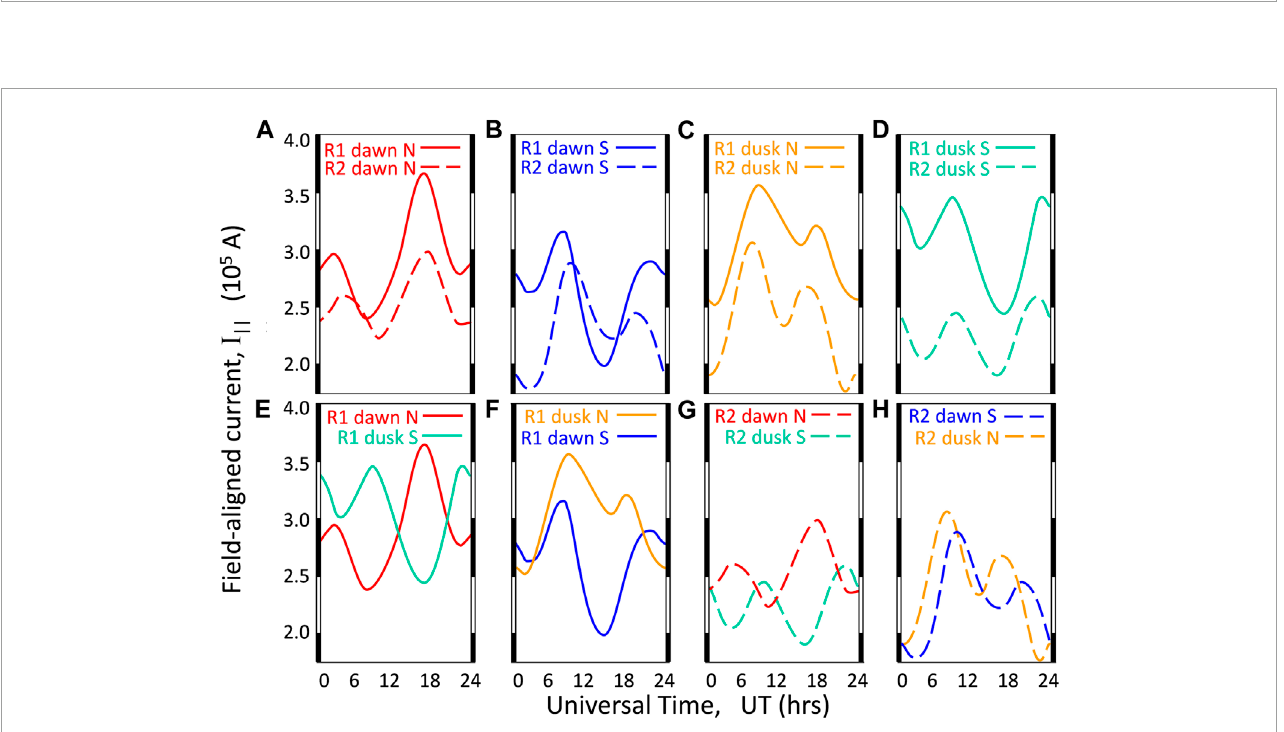
FIGURE 17 The UT variations of field-aligned currents in 6-h MLT windows around 06 and 18 h (dawn and dusk) defined by the AMPERE project from magnetometers on board the Iridium satellites. The upper panels compare the Region 1 (R1) currents (solid lines) and corresponding Region 2 (R2) currents (dashed lines). The lower panels compare currents in opposite hemispheres and opposite dawn-dusk sides of the magnetosphere using the same line types and colors as the upper panels. Data are for 2010–2016,